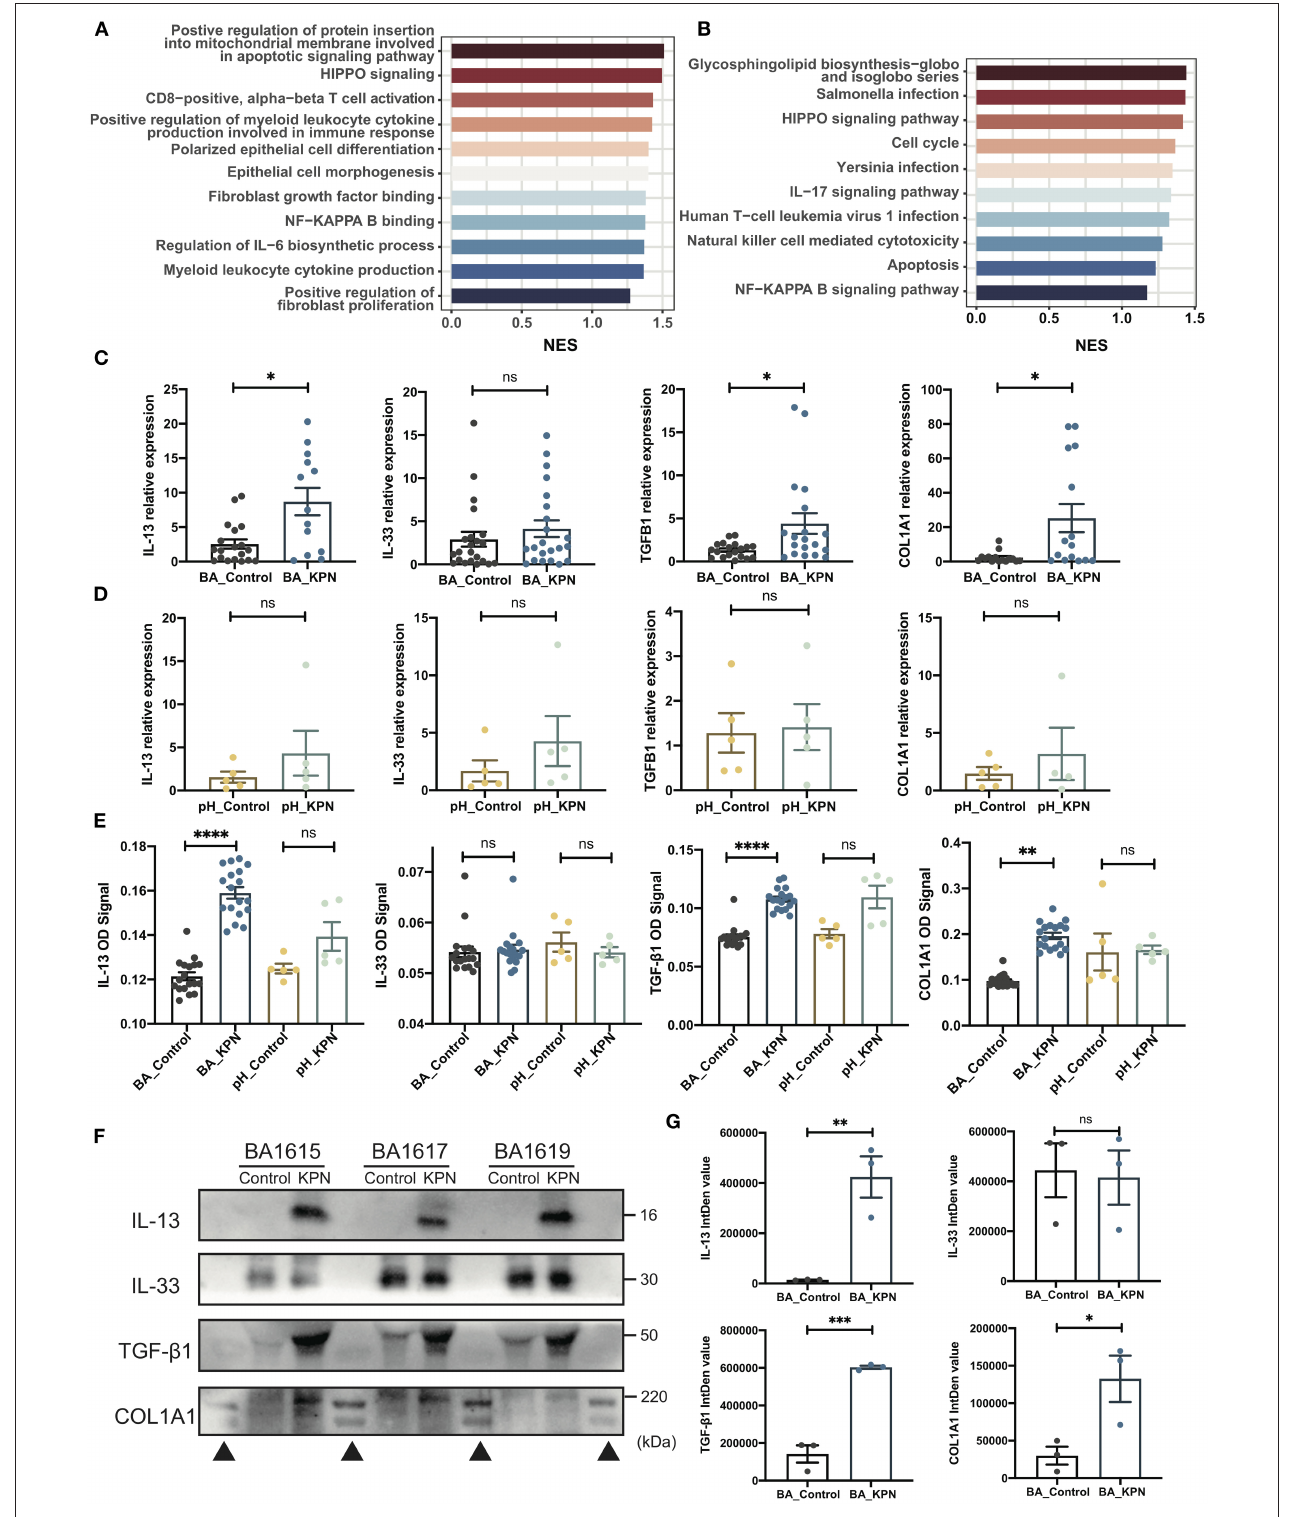
FIGURE 4 | Preliminary study of the mechanism underlying fibrosis in post-Kasai cholangitis. (A,B) Enriched pathways determined by GO and KEGG analysis presented as bar plots, including infection-, immune-, and fibrosis-associated pathways. Length indicates the normalized enrichment score (NES). Color (blue to